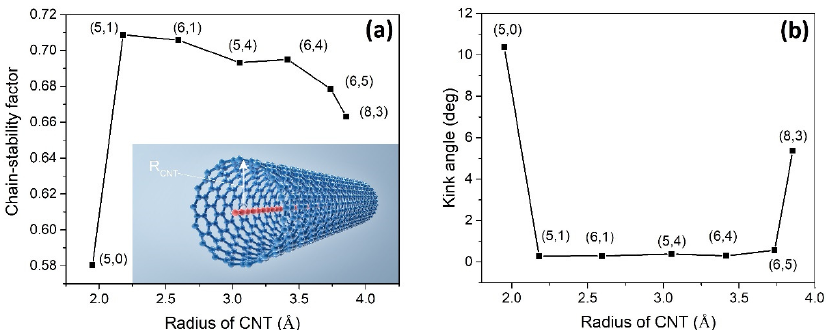
Figure 3. ( a ) The stability of the 6000-atom-long carbyne@nanotube depends on the radius of carbon nanotube R CNT and the chirality (N c ,M c ). The red chain is LCC while the blue tube is CNT. The temperature of the thermal bath is 300 K. For the chain stability factors near 0.7, the average bond lengths of the LCCs range from ~1.3 to ~1.4 Å. ( b ) The average kink angles of the internal LCCs are plotted accordingly. A kink angle of zero (or pivot angle = 180 ◦ ) means that the chain is linear. The standard deviation of the LCC@(6,4)CNT is as low as ~0.1.